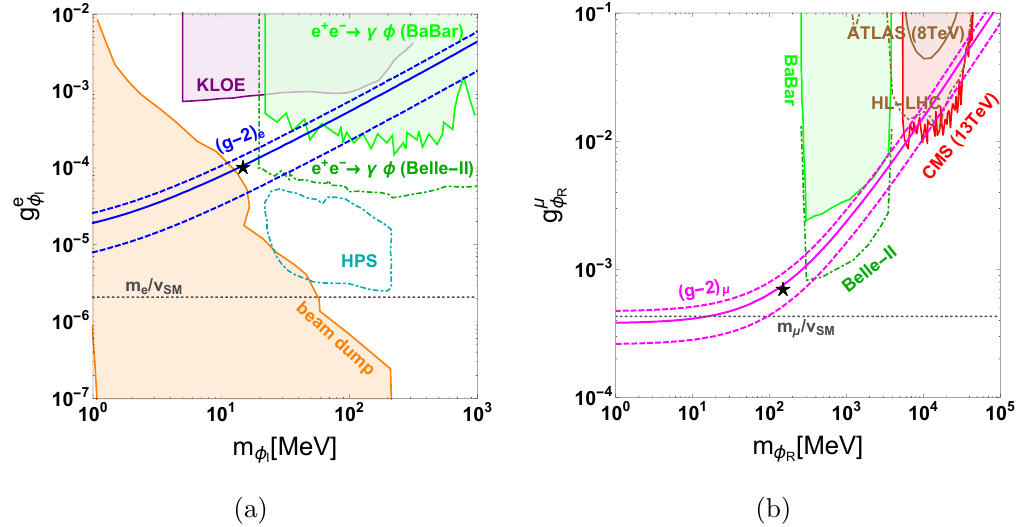
Figure 1 . The color shaded regions with solid boundary are excluded by current experiments, the regions with dot-dashed boundaries are future projections. The black star corresponds to the benchmark in table. 2. (a): the parameter space ( g e ; m (cid:30) ) for (cid:1) a e and the constraints from (cid:30) I I di(cid:11)erent experiments. The shaded orange region is from beam dump experiment [67, 68] and the dot-dashed dark cyan contour area is from future projection for HPS [68, 76]. The collider limits include shaded green region searching for e + e (cid:0) (cid:13)(cid:30) at BaBar [78], shaded purple region from ! KLOE [81, 82] and Belle-II projection [68, 79] which is shown in dot-dashed green contour region. (b): the parameter space ( g (cid:22) ; m (cid:30) ) for (cid:1) a (cid:22) and the constraints from collider searches. BaBar (cid:30) R R search via e + e (cid:0) (cid:22) + (cid:22) (cid:0) (cid:30) is shown in the shaded green region [68, 84] and future projection for ! Belle-II [84] is shown by the green dot-dashed contour. The ATLAS experiment has looked for exotic Z decay Z 4 (cid:22) at LHC Run-I, which has been re-casted for scalar mediator by ref. [84] ! , and the limits for both Run-I and HL-LHC are shown by shaded brown region and dot-dashed brown contour. The CMS collaboration has studied a similar process at 13 TeV with an integrated luminosity of 77 : 3 fb (cid:0) 1 , but required a dilepton resonance from two opposite-sign muons [86], which leads to the exclusion of the red shaded region.